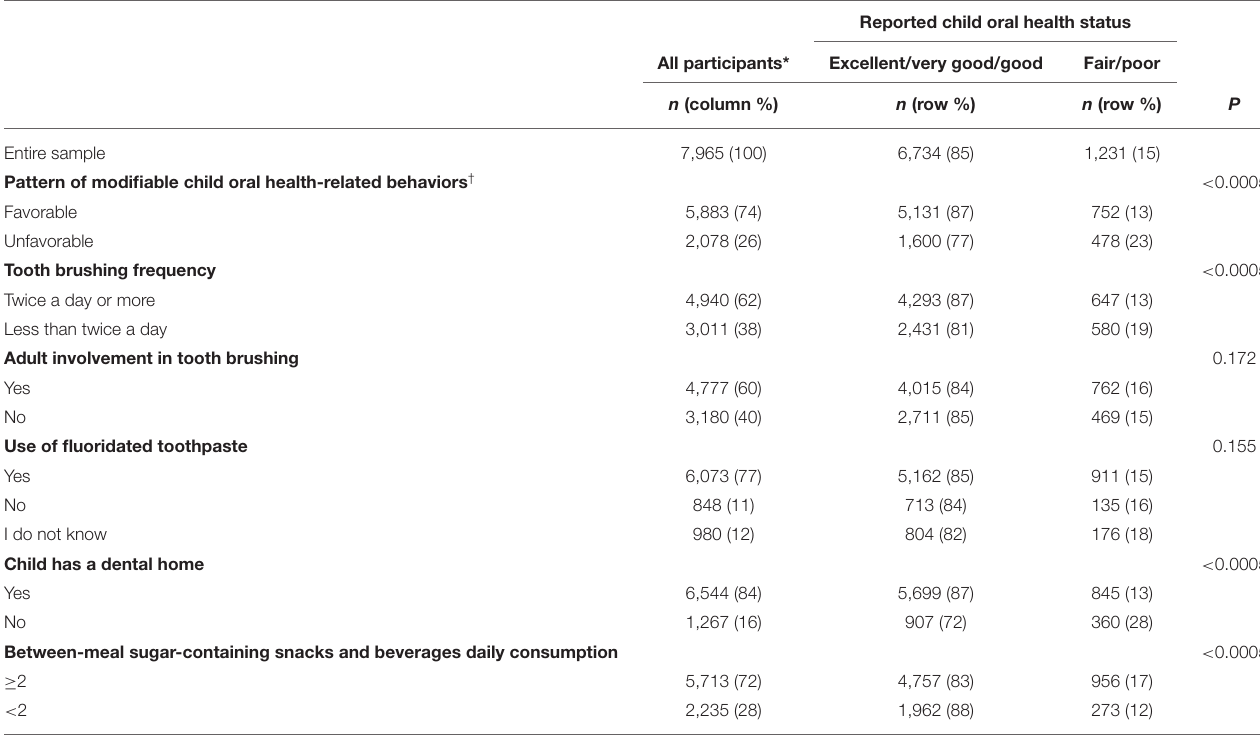
TABLE 2 | Guardian-reported child oral health-related behavior information in the ZOE 2.0 study sample, overall and stratified by child reported oral health status.